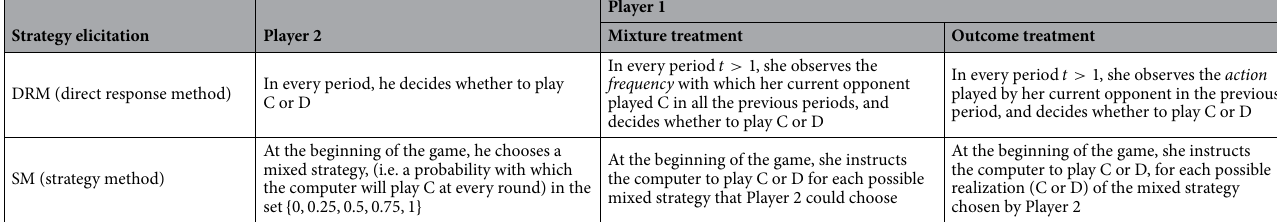
Table 1. Overview of the experiment. We elicited subjects’ strategies using two different methods. In the Direct Response Method, subjects chose in every period whether to play C or D. In the Strategy Method, subjects submitted their strategies only once, in the form of simple computer programs. For each Method, we run two treatments. In the Mixture treatments, subjects playing as Players 1 could base their decision on the frequency with which the opponent played C in the previous periods. In the Outcome treatments, they could base their decision only on the action taken by their opponent in the previous period. Note that subjects playing as Players 2 had the same strategy set in both treatments.